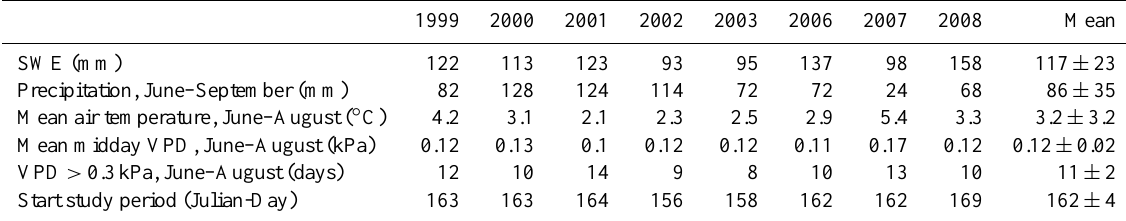
Table 1. Meteorological conditions during the study period (1999–2008), including Snow Water Equivalent (SWE) prior to snowmelt; total precipitation from June through September; mean air temperature June through August; mean midday (12:00 through 16:00) air vapor pressure deficit (VPD); and the number of days that experienced a VPD above 0.3kPa. Mean precipitation and air temperature, 1999–2008 (86mm and 3.2 ◦ C, respectively), were near the long-term (1979–2008) conditions of 99mm and 3.4 ◦ C, respectively. The end of the study period was 31 August (Julian day 242).